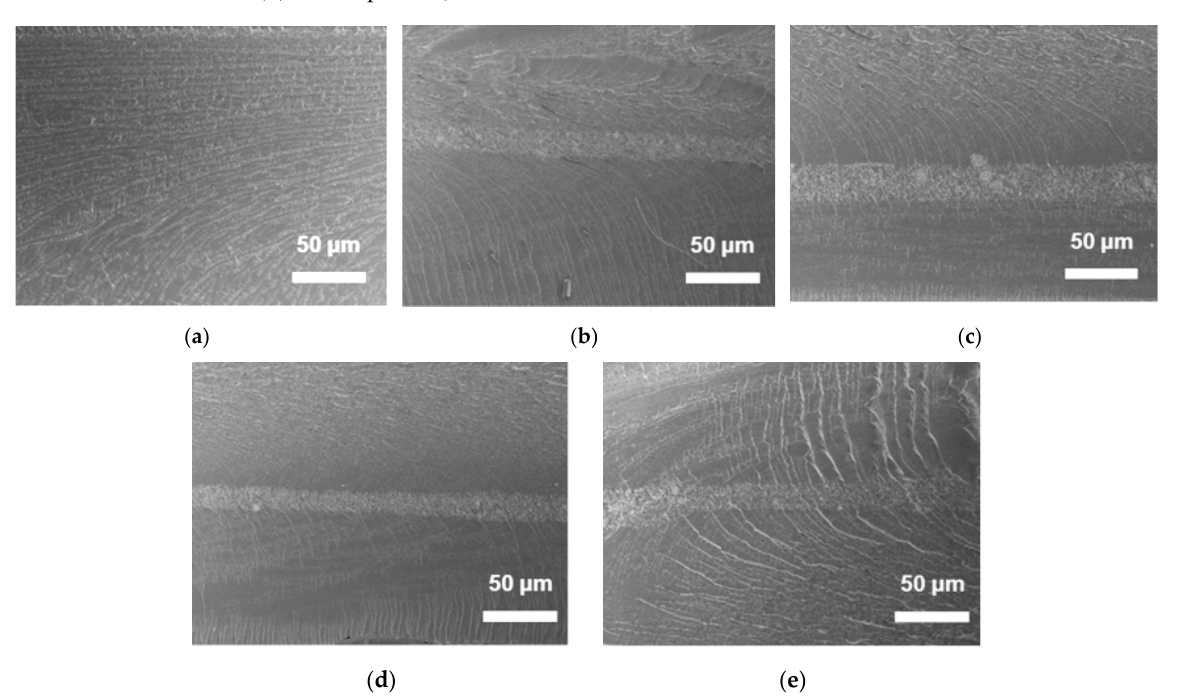
Figure 5. Cross ‐ sectional SEM images of ( a ) PFSA, ( b ) PFSA@PAN, ( c ) PFSA@PAN/TpPa ‐ SO 3 H ‐ 1, Figure 5. Cross-sectional SEM images of ( a ) PFSA, ( b ) PFSA@PAN, ( c ) PFSA@PAN/TpPa-SO 3 H-1, ( d ) PFSA@PAN/TpPa ‐ SO 3 H ‐ 3, and ( e ) PFSA@PAN/TpPa ‐ SO 3 H ‐ 5. ( d ) PFSA@PAN/TpPa-SO 3 H-3, and ( e ) PFSA@PAN/TpPa-SO 3